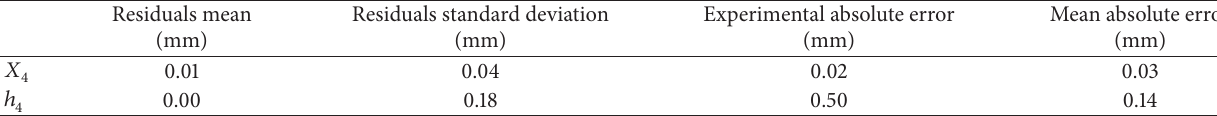
Table 5: Experimental and estimate errors in final diameter and thickness estimation.